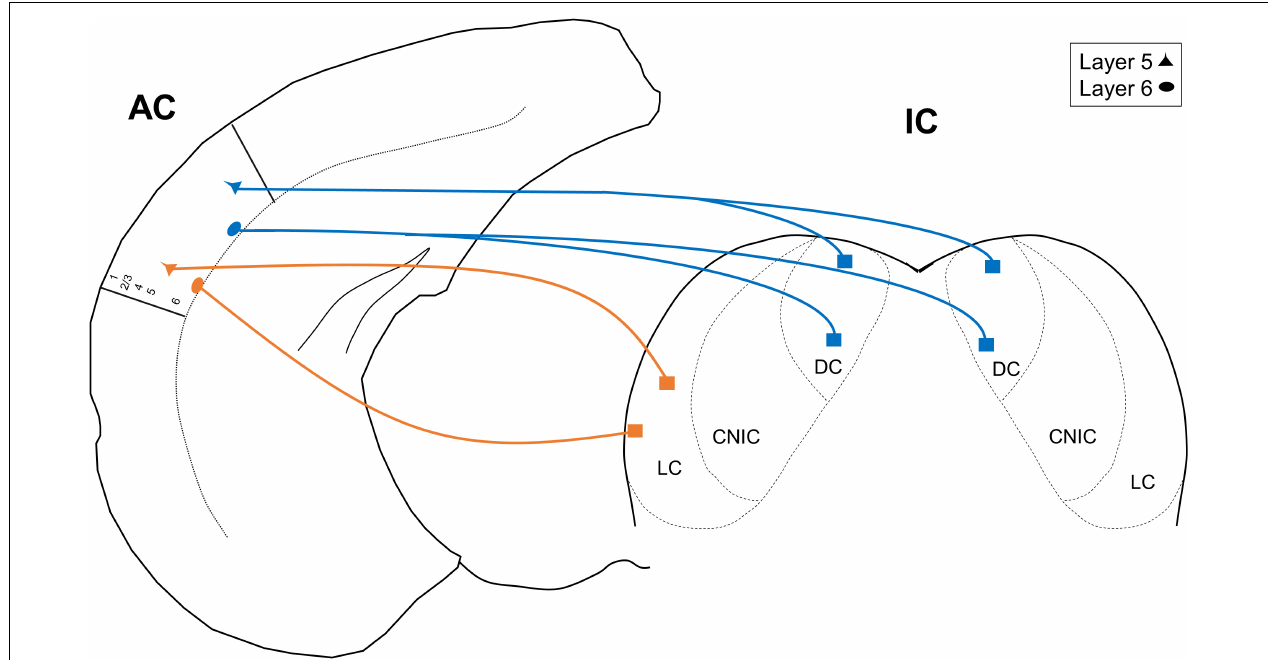
FIGURE 5 | Model depicting the unilateral and projections from layers 5 and 6 of the AC. CNIC, central nucleus of the IC.